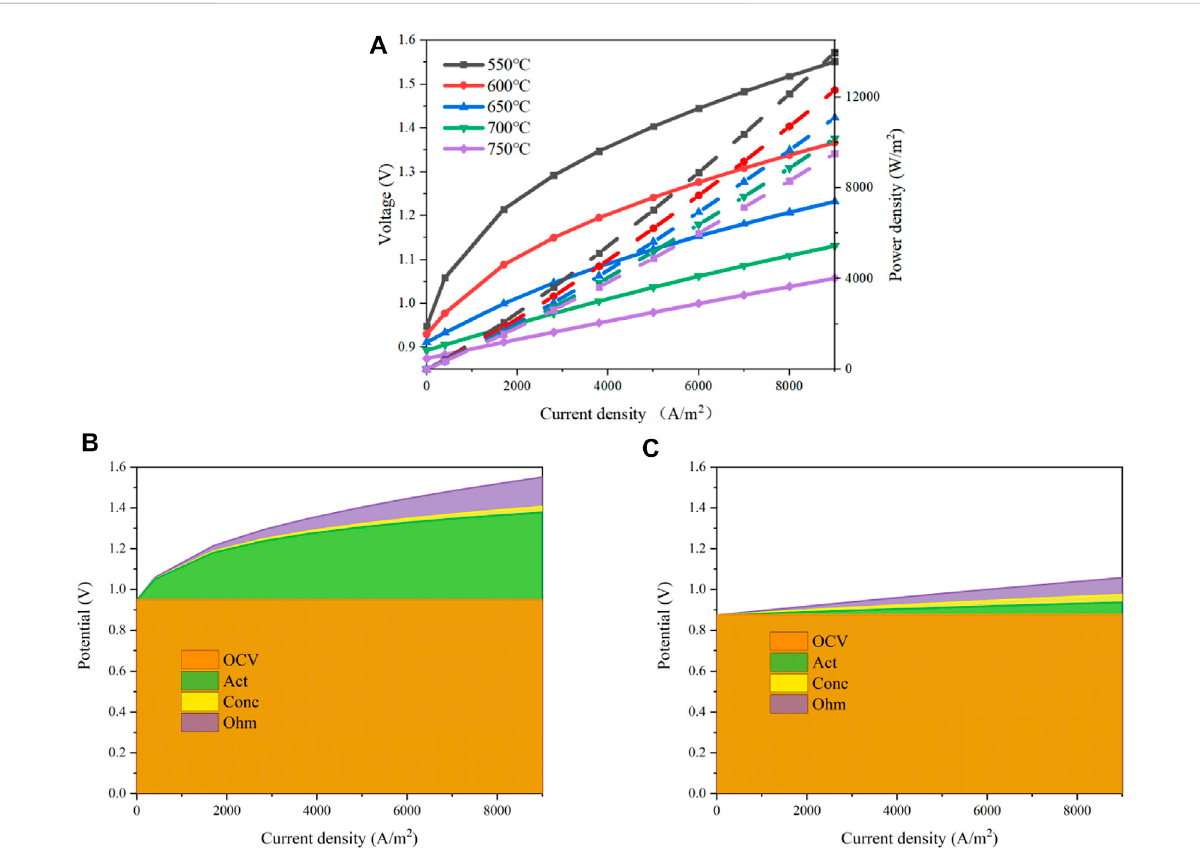
FIGURE 8 Performances of the designed MS-SOEC under various operating temperatures: (A) polarization curves; (B) overpotential losses with an operating temperature of 550 ° C; (C) overpotential losses with an operating temperature of 750 °